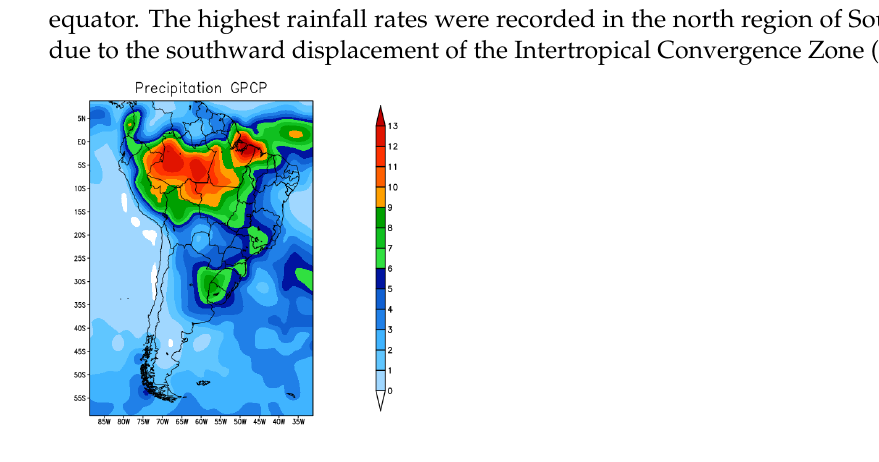
Figure 2. GPCP precipitation—summer 2019.